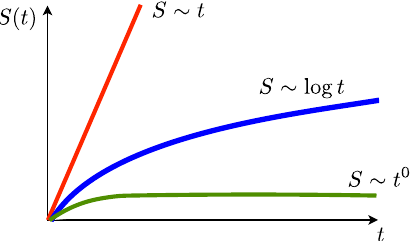
FIG. 2. Schematic illustration of entanglement production after a quench from a product state in 1 þ 1 D. The growth of bipartite entanglement entropy between the two semi-infinite halves of an infinite chain is shown. In the entangling phase ( p < p ; upper c curve), the entanglement grows “ ballistically ” with time. At the critical point ( p ¼ p ; middle curve), the entanglement grows c logarithmically. In the disentangling phase ( p > p ; lower c curve), the entanglement saturates to a finite value. (Random fluctuations are averaged over.)